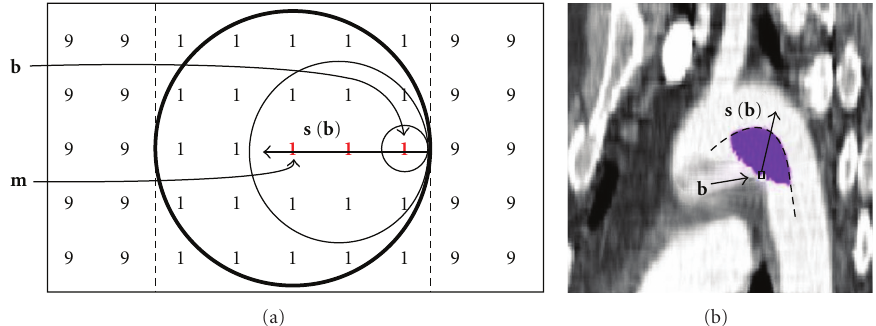
Figure 11: (a) Diagram of an object with intensity 1 between two regions of intensity 9, showing set S − 1 ( b ) of pixels (bold) whose spheres contain pixel b . This set produces an s ( b ) vector (see text) along which the furthest bold pixel m is the center of a medial sphere (circle in bold) touching both boundaries (dashed lines). (b) Image of a 2D slice through a CT scan of the aorta with contrast showing an actual S − 1 ( b ) set (purple), the resulting s ( b ) vector, and the medial manifold (dashed curve) on which the furthest sphere along s ( b ) must